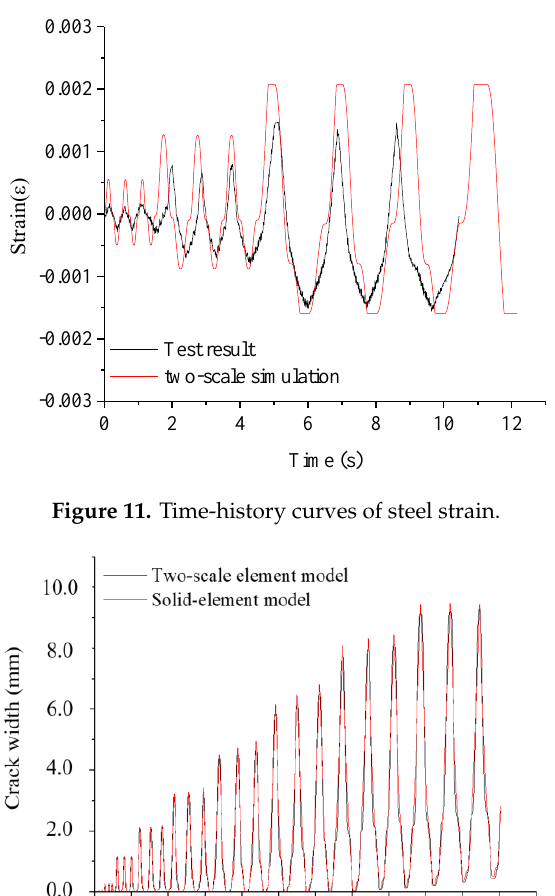
Figure 10. Failure pattern of tested RC columns with different axial compression ratios (ACRs).